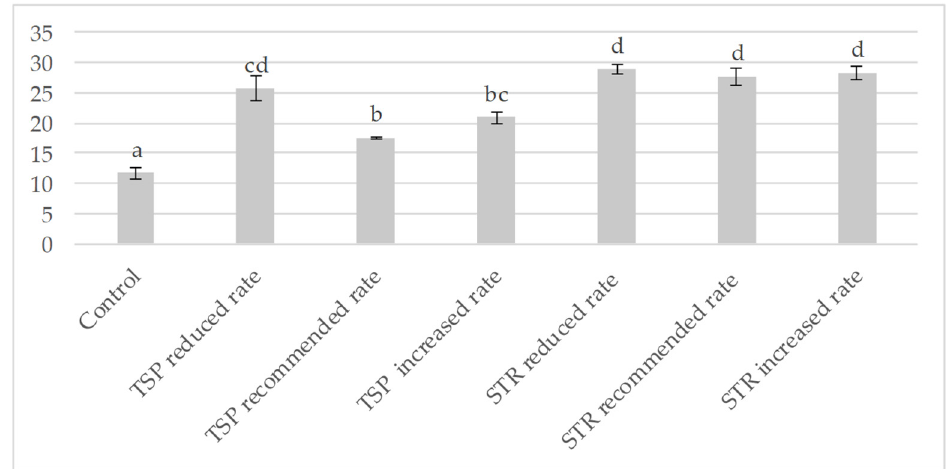
Figure 1. Phosphorus content in butterhead lettuce leaves (mg kg − 1 DM) as affected by interaction of examined factors (A × B) at the level of significance α = 0.05 ( p value < 0.001).